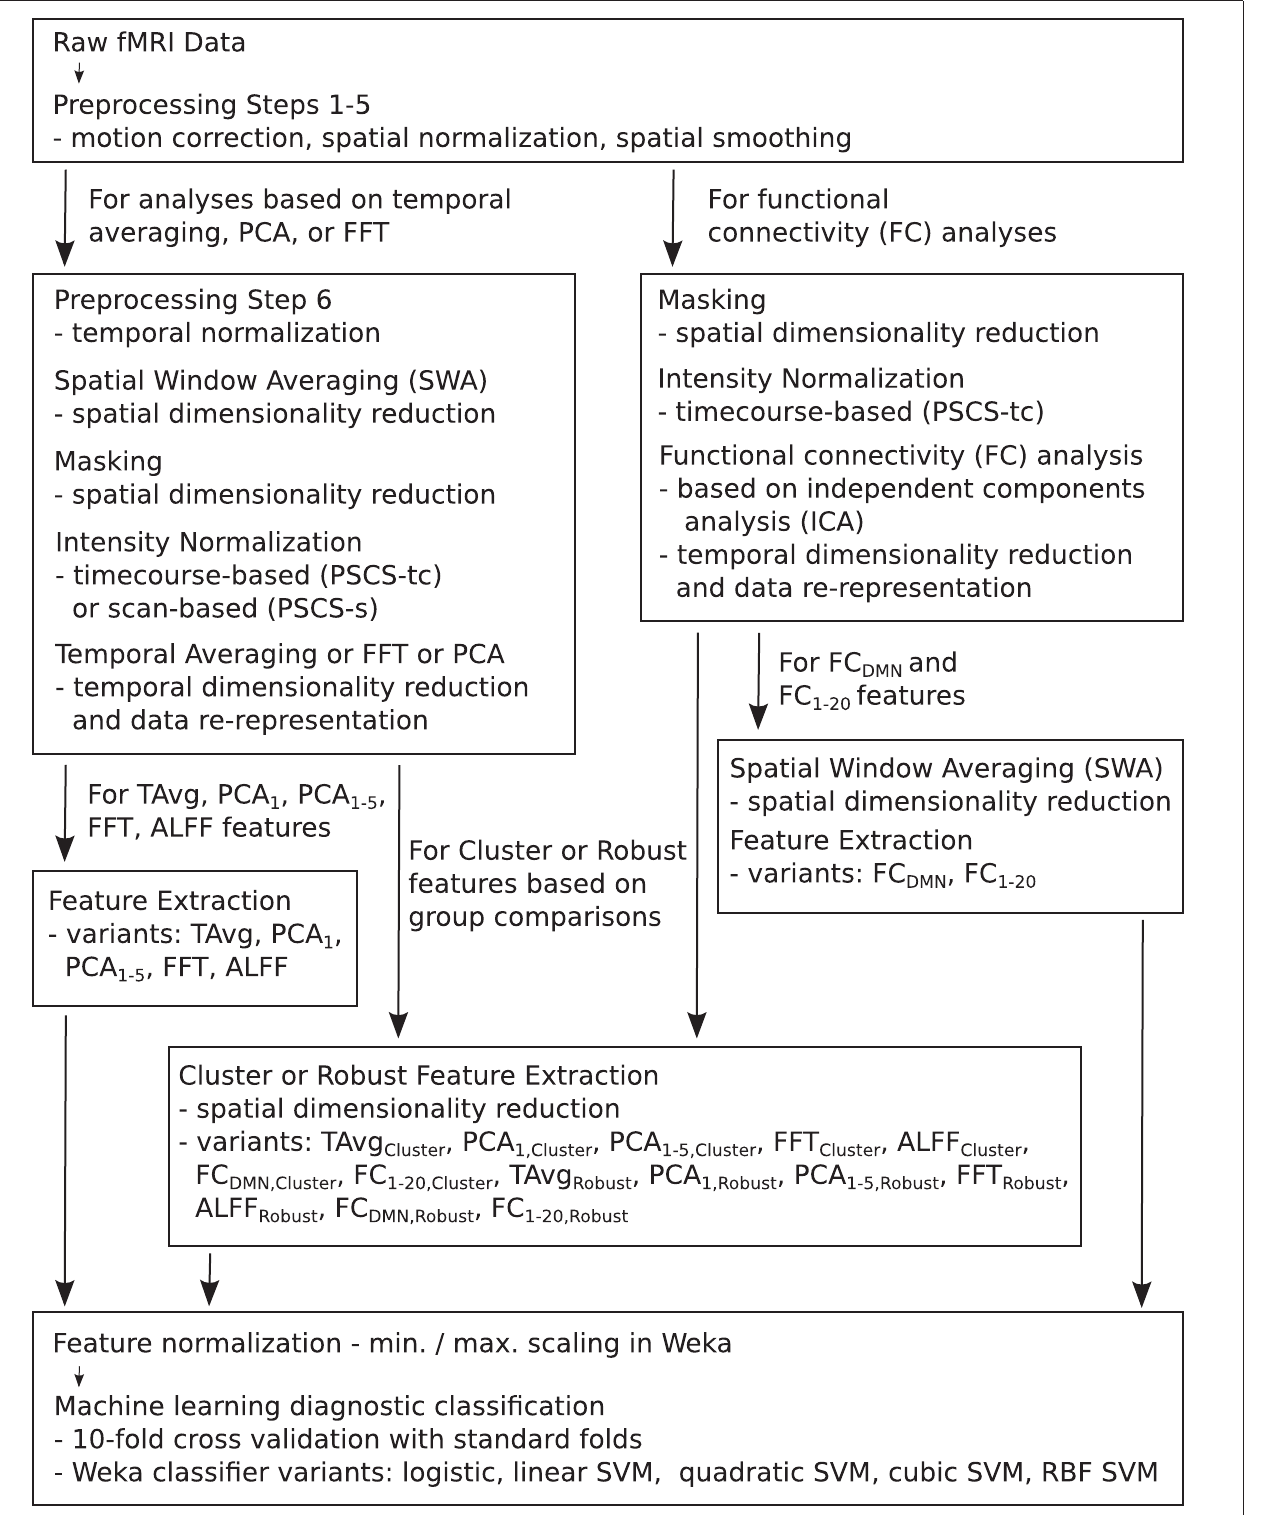
Frontiers in Systems Neuroscience